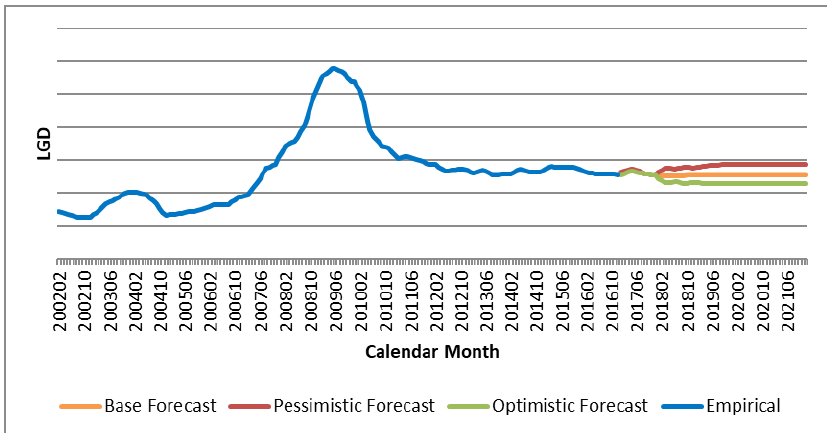
Figure 7. LGD by calendar month including forecasts for different